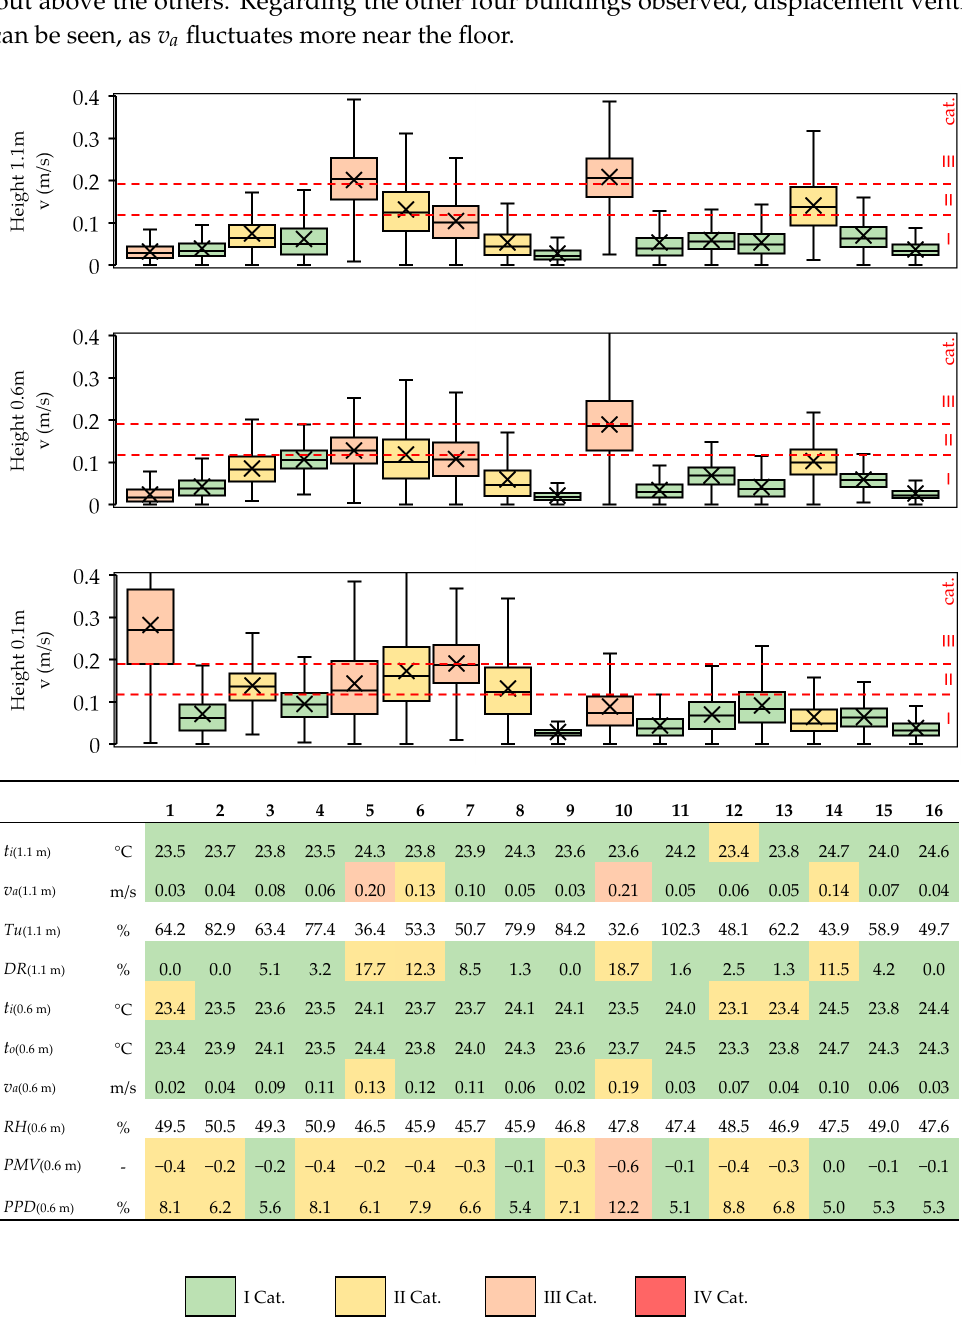
Figure 5. Building B air velocity results in measurement points 1–16 and the thermal comfort parameters.